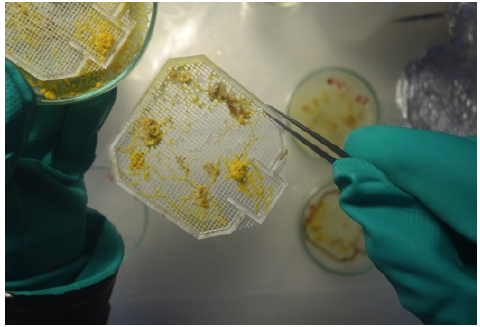
Figure 8. Documentation process of the